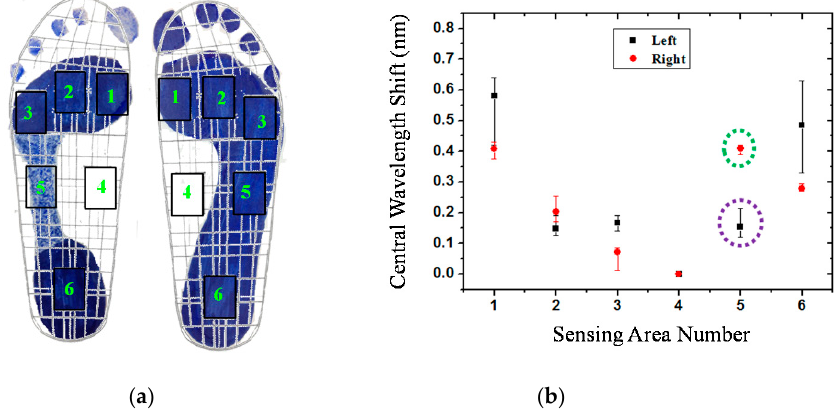
Figure 11. The plantar pressure distribution of participant No. 11, whose left foot is cavus and right foot is neutral: ( a ) Footprint; ( b ) central wavelength shift as a function of sensing area number.